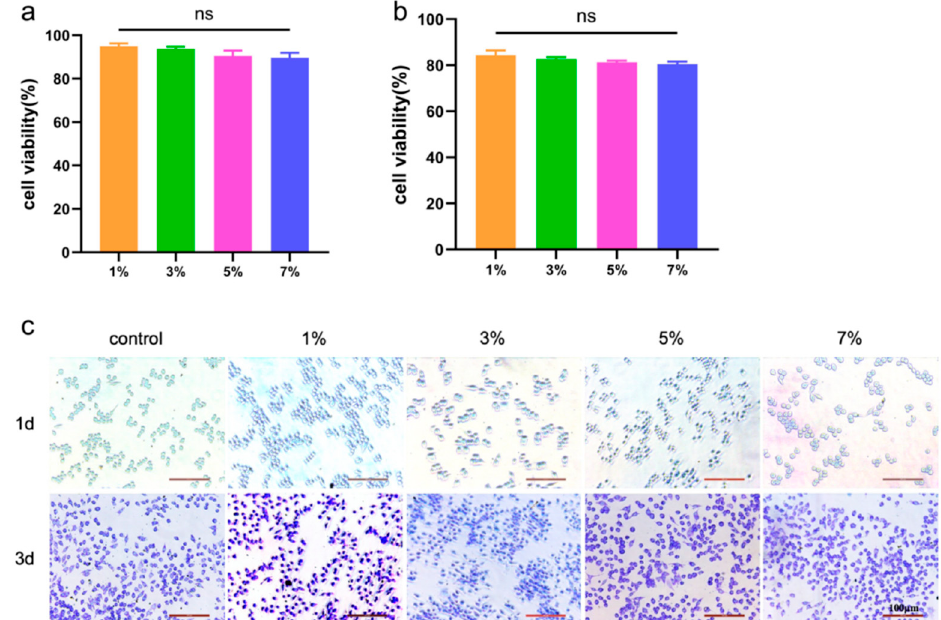
Figure 7. Effect of chitosan concentration on cell viability. RAW264.7 cells were cultured with different concentrations of chitosan freeze-dried scaffold extract, and the cell viability was measured using CCK-8 method at 1d ( a ) and 3d ( b ), n = 8, ns represents p > 0.05. Then, RAW264.7 cells were stained with TBO ( c ).